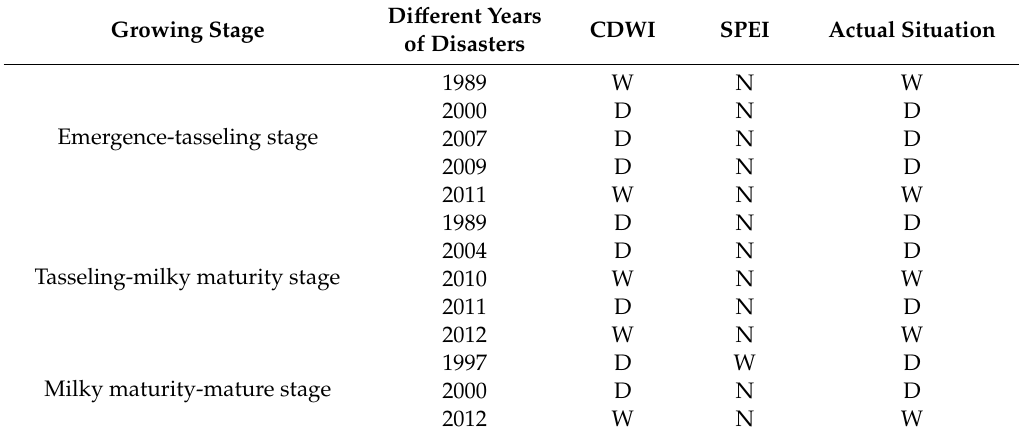
Table 2. Comparison of drought and waterlogging conditions based on the CDWI, SPEI, and historical records of the di ff erent years of disasters resulting in maize yield loss (D, W, and N represent drought, waterlogging, and normal year,